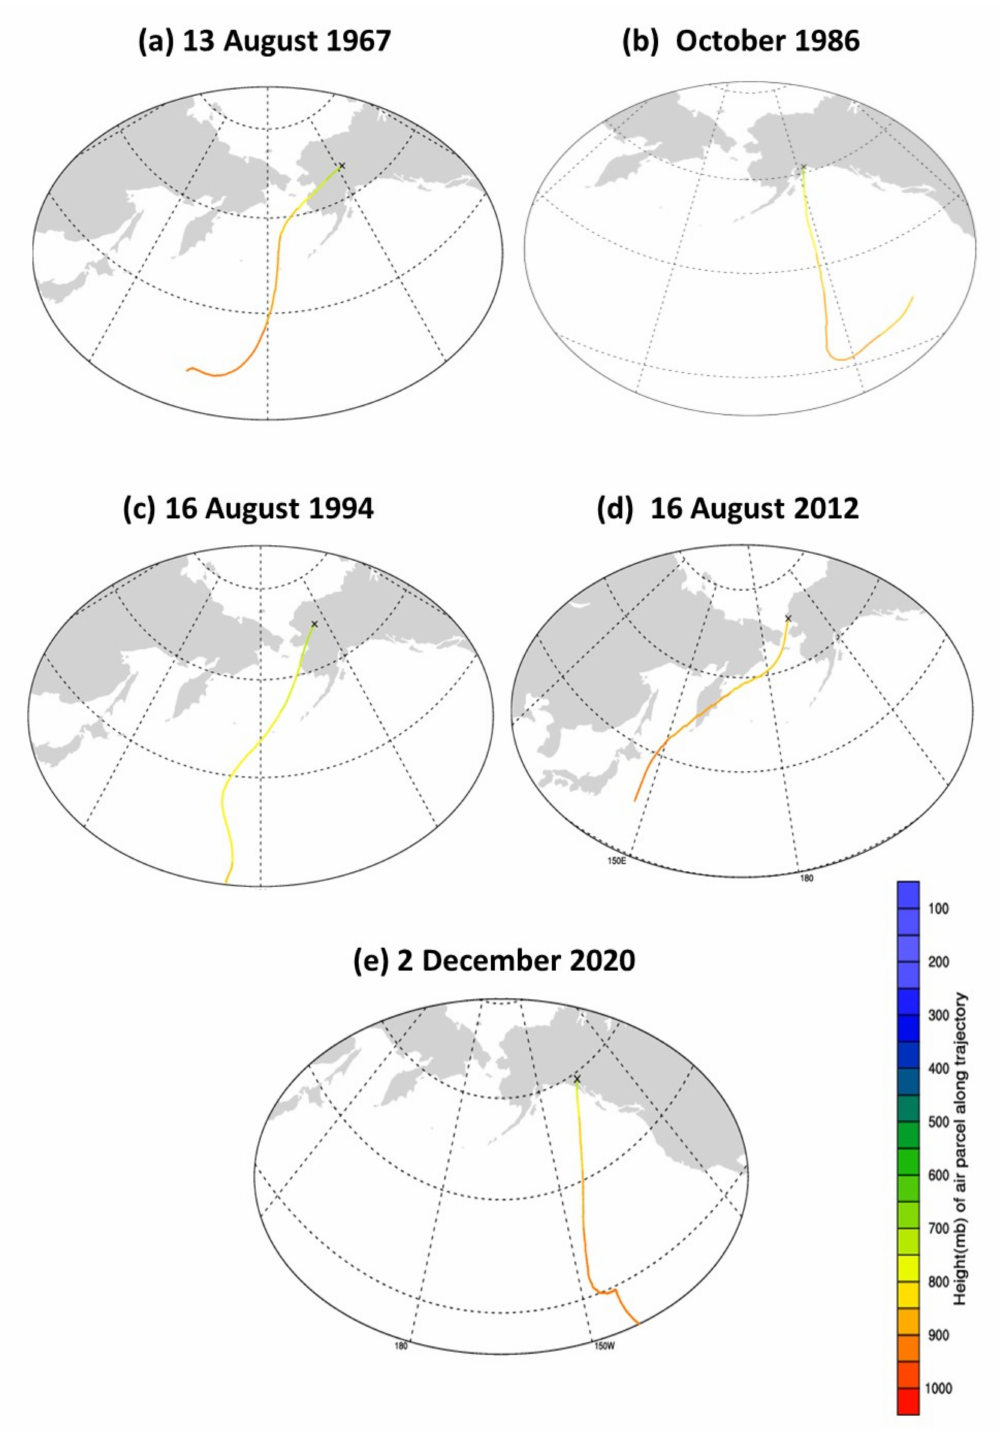
Figure 4. Trajectories of air arriving in lower middle troposphere (700 hPa) during heavy precipitation associated with the five flood events. ( a ) Fairbanks: 13 August 1967, ( b ) Seward: 11 October 1986, ( c ) Allakaket/Bettles: 16 August 1994, ( d ) Kivalina: 16 August 2012, ( e ) Haines: 2 December 2020. Colors (scale at lower right) depict pressure (altitude). Plots were created using NCEP/NCAR reanalysis and Web-based Trajectory Tool of NOAA’s Physical Sciences Laboratory, https://psl.noaa. gov/cgi-bin/data/trajtool/traj.pl (accessed on 27 January